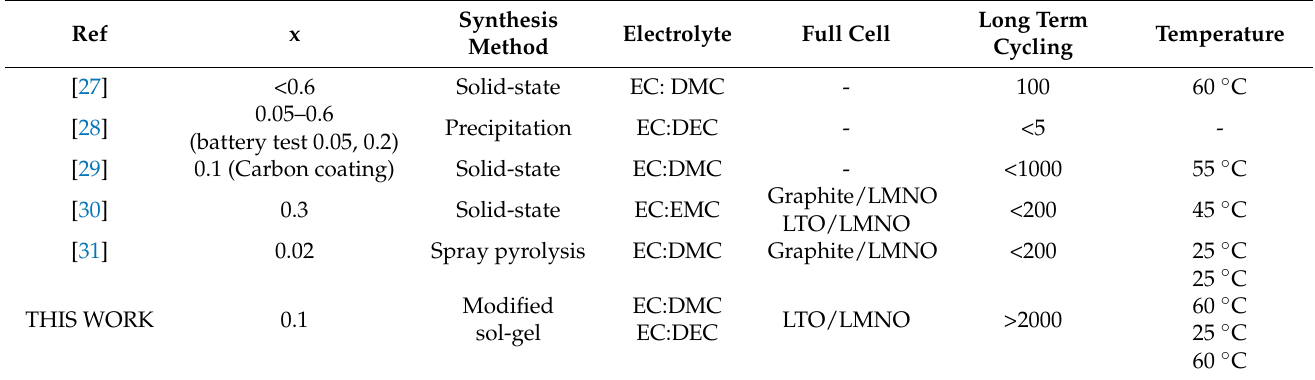
Table 1. Summary of Ti-doped LMNO, LiMn 1.5 − x Ni 0.5 Ti x O 4 , reported in the literature with battery performance as a function of a synthetic method, electrolyte type and